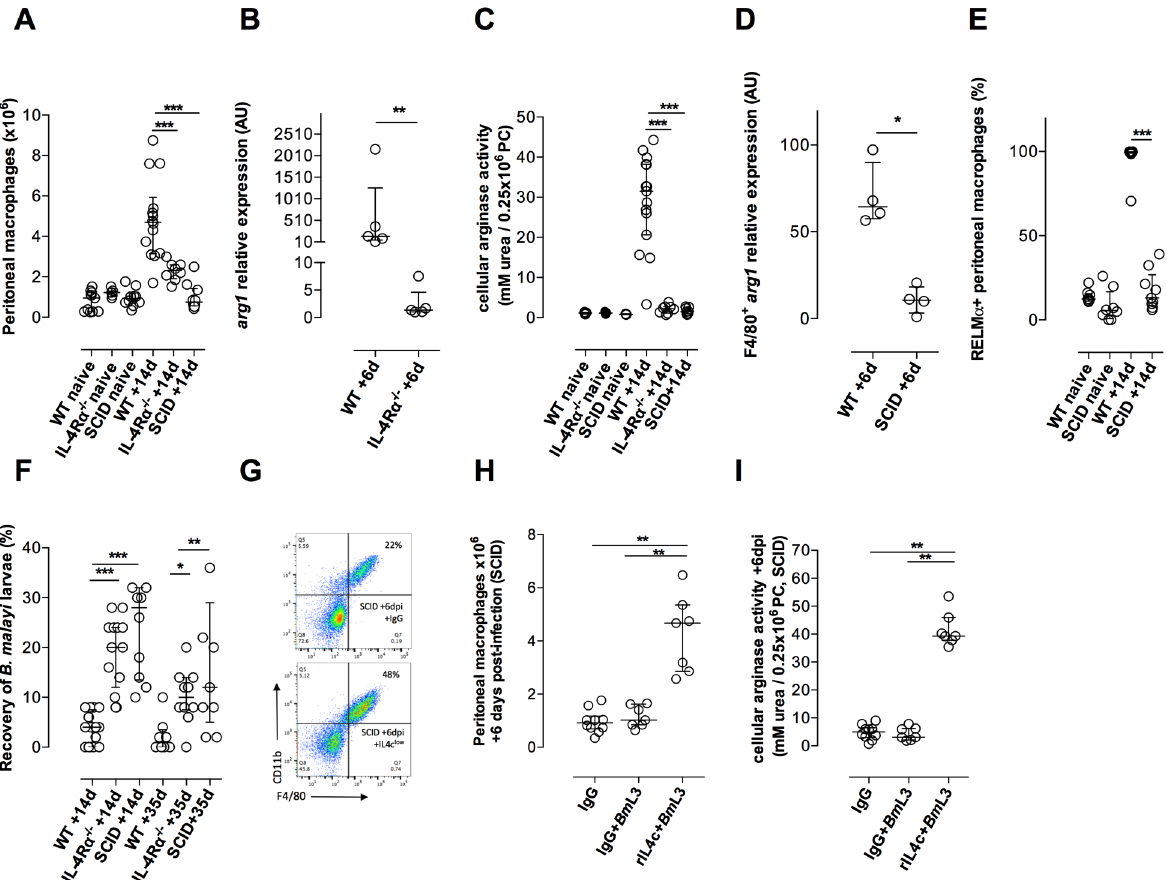
Fig 3. Development of AAM ϕ in response to B . malayi infection requires adaptive-immune IL-4/IL-4R α signalling and is associated with resistance to adult parasite establishment. Expansion of peritoneal M ϕ (A) peritoneal cell (PC) arg1 expression (B) PC arginase activity (C) peritoneal M ϕ arg1 expression (D) M ϕ RELM α expression (E) and recovery of B . malayi (F) at indicated time points post-infection with 50 Bm L3 in BALB/c WT, IL-4R α -/- or SCID mice or in na ï ve controls. Expansion of peritoneal M ϕ (G,H) or PC arginase activity (I) in BALB/c SCID mice +6d post-treatment with recombinant murine IL-4+rat anti-mouse IL-4 monoclonal antibody complex (rIL-4c) or rat IgG control ip treatments with or without infection with 50 Bm L3. Data from individual mice with median and interquartile range are plotted. Significant differences between groups assessed by Mann-Whitney or Kruskal-Wallis + Dunn’s post-hoc tests ( > 2 groups). Data is from an individual experiment or pooled from 2–3 experiments per time-point using groups of 4–6 mice per group / time-point.